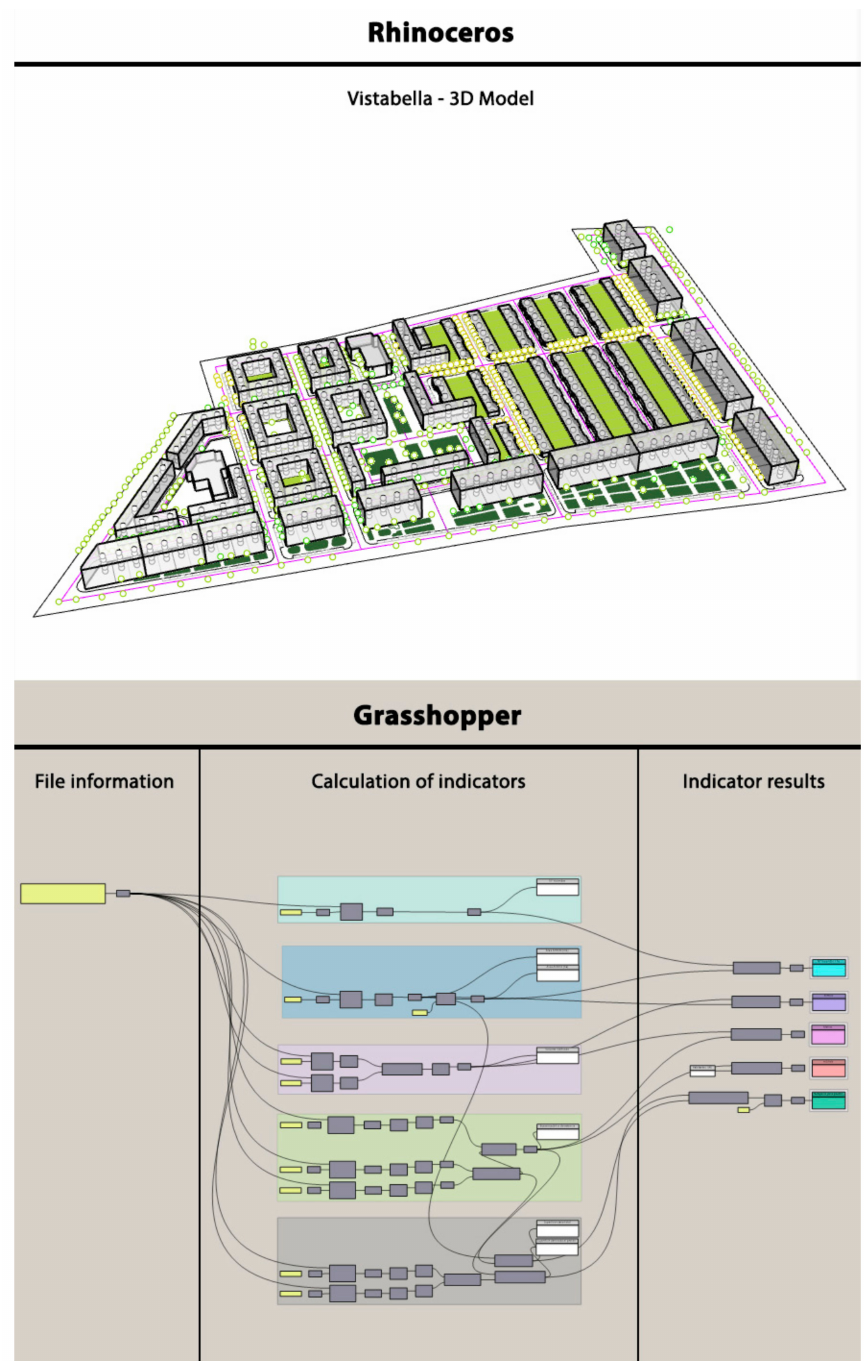
Figure 6. Three-dimensional modeling of the Vistabella district ( top ) and some algorithms for the calculus ( bottom